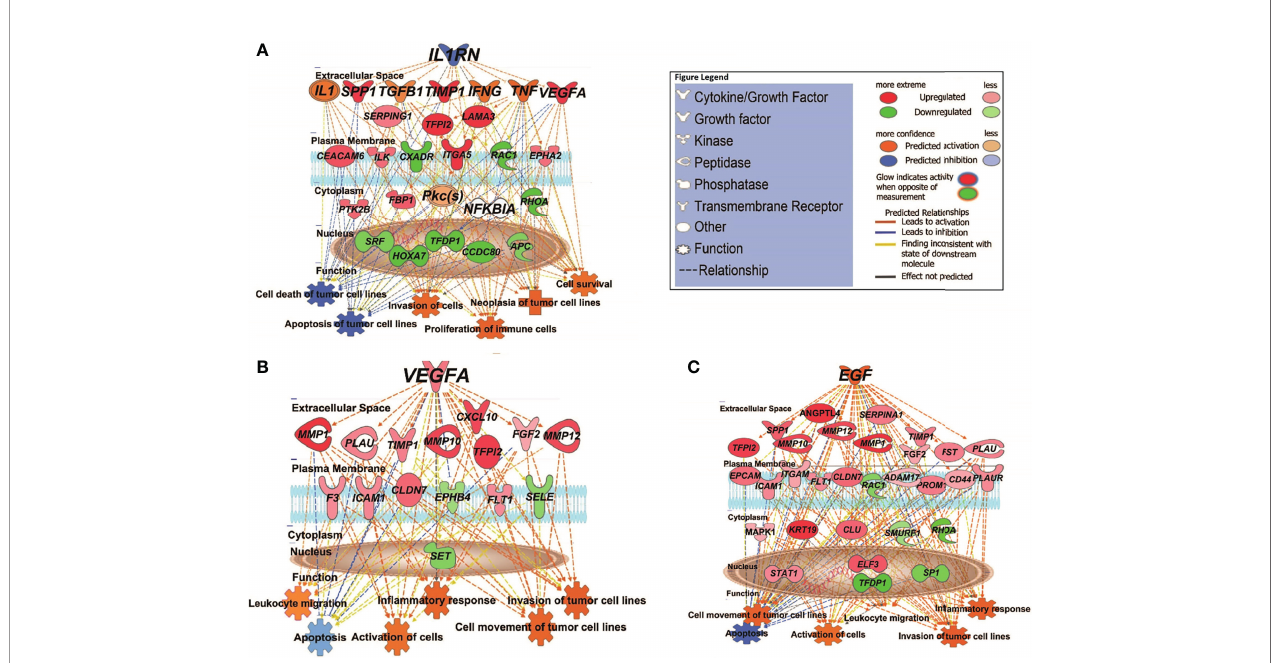
FIGURE 4 | IPA causal network analysis depicting the interactions between upstream regulators, downstream genes, and physiological functions in cSCC. (A) MET vs. PRI+ comparison showing effect of predicted master regulator IL1RN (depth: 2). (B, C) MET vs. PRI- comparison showing predicted master regulators VEGFA (depth: 1) and EGF (depth: 1). Master regulators were predicted based on the causal paths known to in fl uence the expression of their target genes leading to the physiological functions shown. Regulators with depth of 2 in fl uence the expression of target genes via other regulators. Figure legend indicates whether genes were upregulated or downregulated in MET relative to PRI tumors; the predicted activation state of the upstream regulators, and the predicted relationships between these and downstream genes and